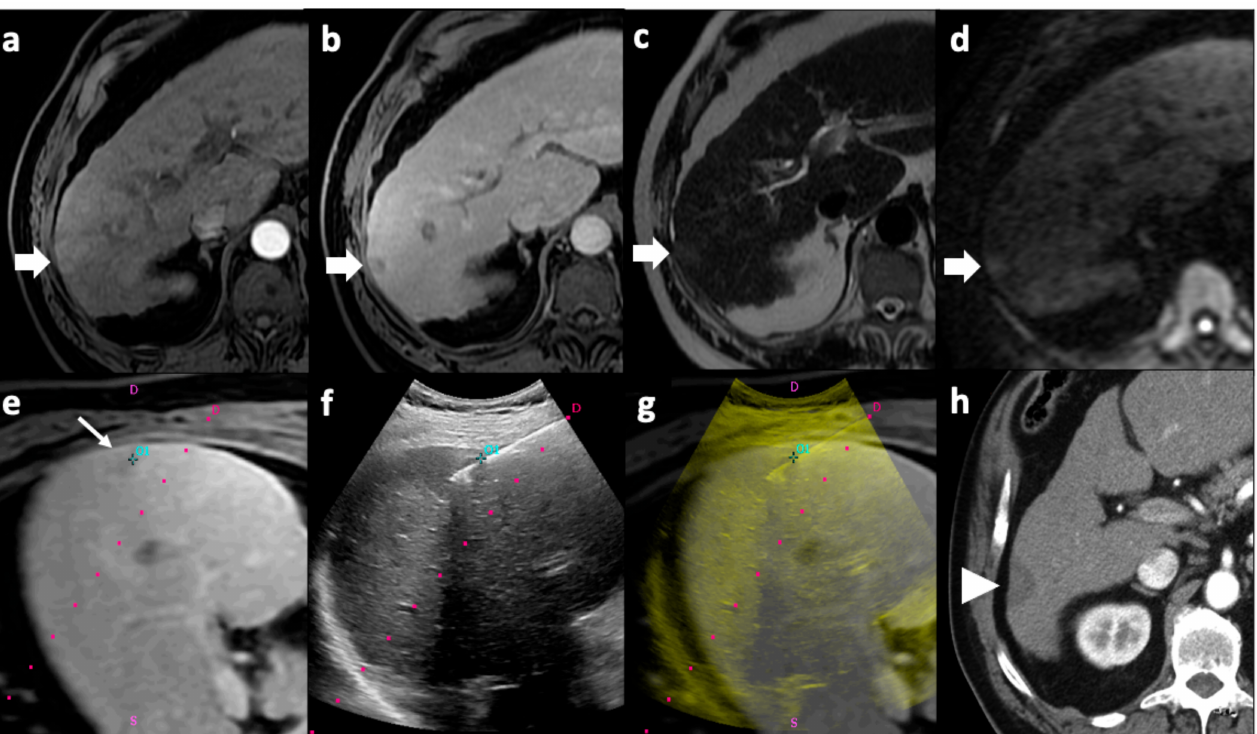
Figure 2. Microwave ablation of an HCC nodule. Pre-procedural MRI axial images demonstrated a focal right liver lesion with arterial wash-in (arrow, a ), venous wash-out (arrow, b ), hyperintensity on T2-weighted images (arrow, c ), and diffusion restriction (arrow, d ). The tumor was not clearly visible on US examination; thus, pre-procedural MR images in which the tumor was clearly detectable (thin arrow, e ) were fused with real-time US images in which the microwave antenna could be monitored ( f ) during procedure; 01 corresponds to the point where the target lesion was selected on pre-procedural images. A fused MR–US image was produced showing the antenna correctly positioned inside the nodule ( g ). The red dot line in images ( e – g ) indicate the predicted path of the antenna when a needle guidance system is used, but in this case guidance was used only to enter liver parenchyma, not for precisely inserting the antenna inside the nodule. Follow-up axial CT imaging performed 1 month after the procedure showed a hypodense image consisting with the ablation zone (arrowhead, h ) with no enhancement in the arterial phase, consistent with the absence of residual disease. CT: computed tomography; HCC: hepatocellular carcinoma; MRI: magnetic resonance; US: